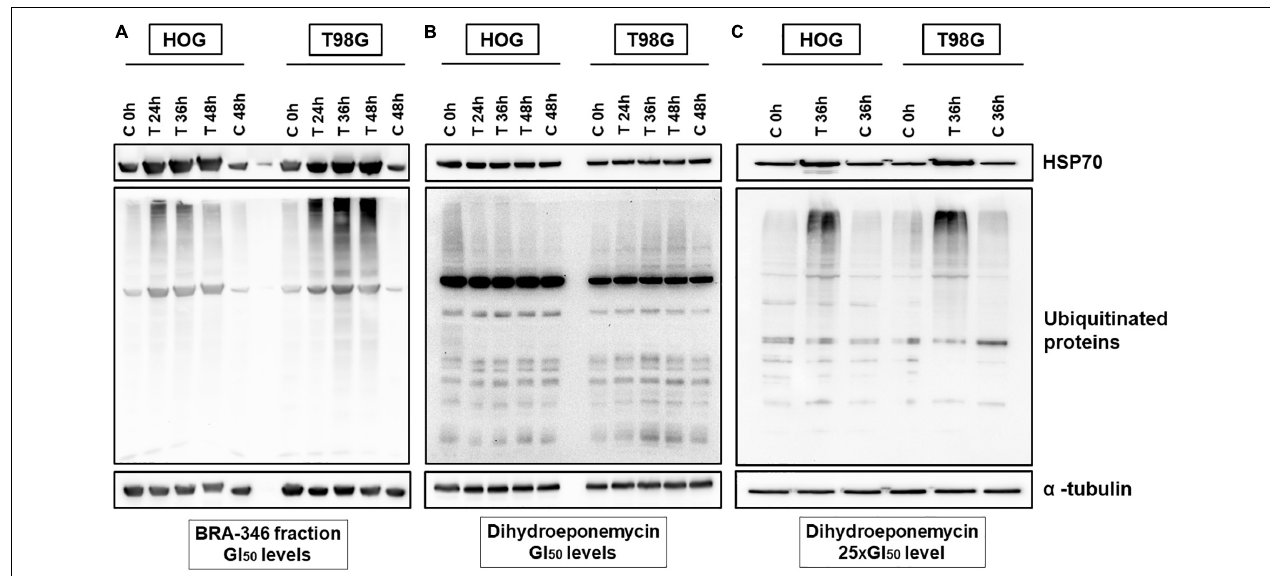
FIGURE 5 | Dihydroeponemycin (DHE) and BRA-346 epoxyketone-containing fraction led to the accumulation of ubiquitinated proteins and HSP70 in glioma cell lines HOG and T98G. (A) Glioma cells treated with BRA-346 fraction at GI 50 levels (17.6 and 28.2 ng/mL for HOG and T98G, respectively) for 3 different times of exposition (24, 36, and 48 h). (B) Glioma cells treated with DHE at GI 50 levels (1.6 and 1.7 ng/mL for HOG and T98G, respectively) for 3 different times of exposition (24, 36, and 48 h). (C) Glioma cells treated with DHE at 40 ng/mL (100 nM) for 36 h of exposure. Negative controls (DMSO 0.1%) were set at 0, 36, and 48 h. Experiments were repeated three